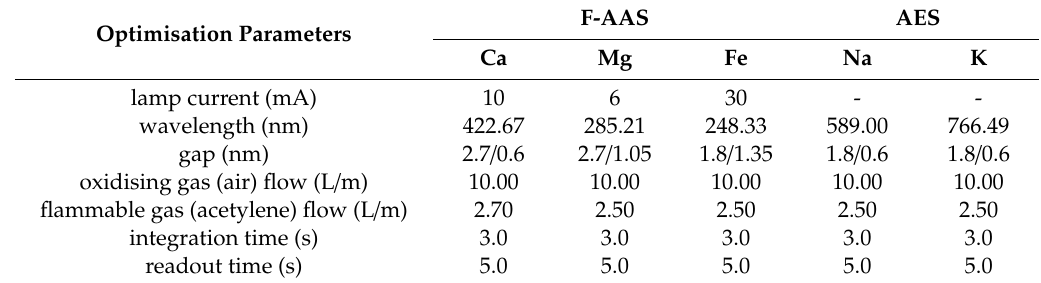
Table A1. The values of optimisation parameters in the Flame Atomic Absorption Spectrometry (F-AAS) and Atomic Emission Spectrometry (AES) methods.